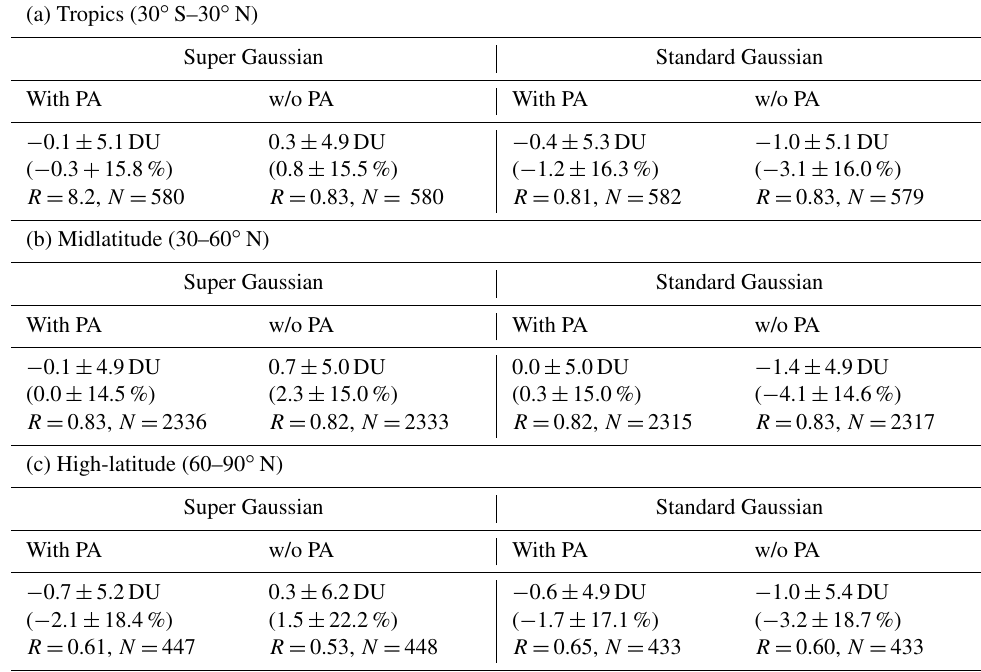
Table 1. Comparison statistics (mean bias and 1 σ standard deviation of absolute (DU) and relative (%) differences, the Pearson correlation coefficient, number of collocations) of OMI and ozonesonde tropospheric column ozone from 2005 to 2008 over (a) tropical, (b) midlatitude, and (c) high-latitude